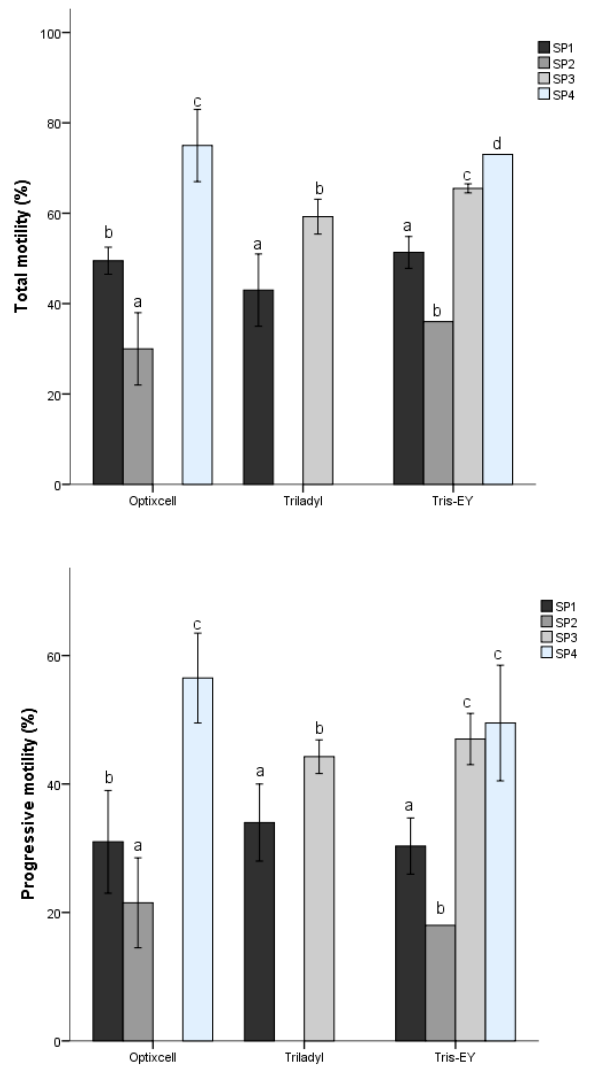
Figure 1. Distribution of total motility and progressiveness of sperm within sub-populations (SPs) between extenders. Different letters (a–d) indicate differences within SPs between extenders. p < 0.05.